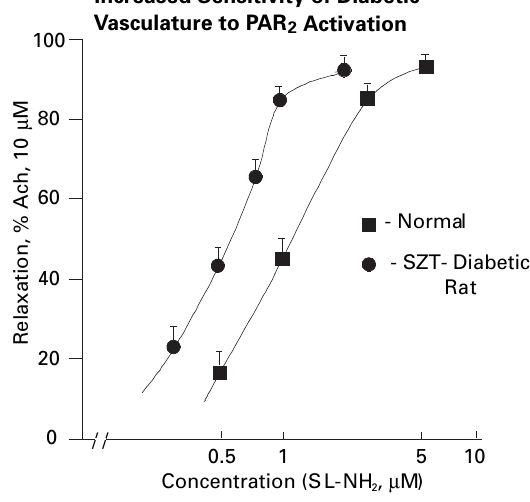
Vasorelaxation of rat aorta from normal and streptozo- tocin diabetic rats following PAR 2 activation. Male Sprague-Dawley rats (about 200 g) were either treated or not with streptozotocin (SZT), to render treated ani- mals diabetic. One week after streptozotocin treatment, with hyperglycaemia established, animals were sacri- ficed and endothelium-intact aorta rings were monitored for PAR 2 -mediated vasodilatation as described previ- ously [14], using SLIGRL-NH 2 (SL-NH 2 ) as a receptor agonist. Relaxation in the normal ( n ) or SZT-diabetic ( • ) aorta rings by increasing concentrations of SL-NH 2 was expressed as a percentage of the relaxation caused in the same preparation by 10 µ M acetylcholine (% Ach). Values showing the shift to the left in sensitivity of the SZT-diabetic tissues represent the averages ( ± sem) for measurements done with three independent tissue preparations. (Saifeddine and Hollenberg,